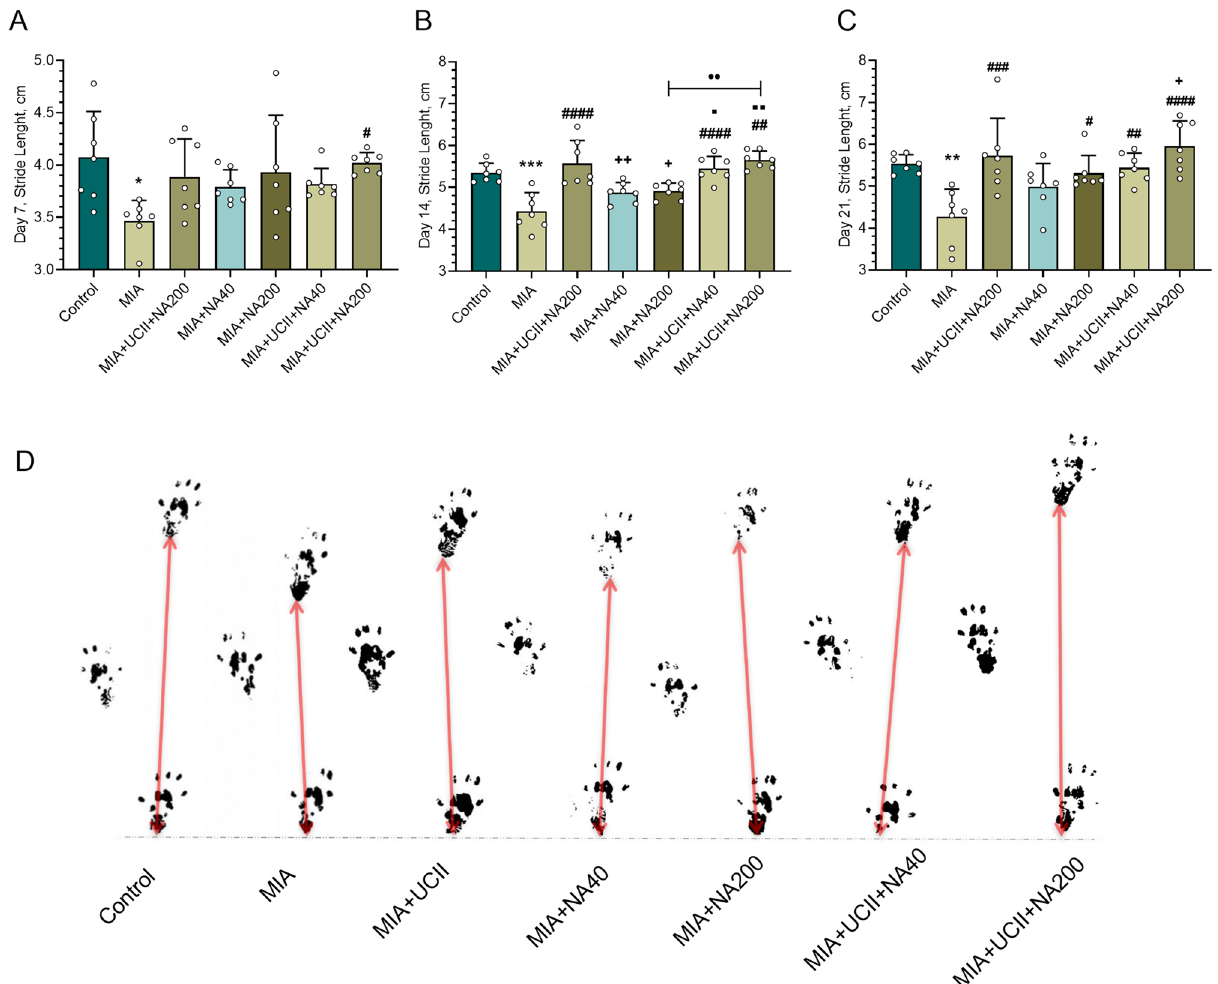
Figure 1. Effects of niacinamide (NA) and undenatured type II collagen (UCII) supplementation on stride length [on days 7 ( A ), 14 ( B ), and 21 ( C )] in monosodium iodoacetate (MIA)-induced osteoarthritis in rats (n = 7). Representative images of the stride length measured on day 21 of the study are shown ( D ). Control as a non-supplemental group with no osteoarthritis-induced rats, MIA as a non-supplemental group with monosodium iodoacetate (MIA)-induced knee osteoarthritis, MIA + UCII as MIA group gavage-fed a supplemental UCII at 4 mg/kg, MIA + NA40 as MIA group gavage-fed supplemental niacinamide (NA) at 40 mg/kg, MIA + NA200 as MIA group gavage-fed a supplemental NA at 200 mg/kg, MIA + UCII + NA40 as MIA group gavage-fed both supplemental UCII at 4 mg/kg and NA at 40 mg/kg and MIA + UCII + NA200 as MIA group gavage-fed both supplemental UCII at 4 mg/kg and NA at 200 mg/kg. Oral gavage delivery of supplements was applied from d7 to d30. The error bars point out the standard deviation of the mean. ANOVA and Tukey’s post-hoc test were used to compare the results among different treatment groups. Statistical significance between groups is shown by: * p < 0.05; ** p < 0.01; *** p < 0.001 compared as Control group and, # p < 0.05; ## p < 0.01; ### p < 0.001; + p < 0.05; ++ p < 0.01 compared as #### p < 0.0001 compared as MIA group and, MIA + UCII group and ⬛ p < 0.05; ⬛⬛ p < 0.01 compared as MIA + NA40 group and, •• p < 0.01 compared as pairwise comparisons between the groups) (ANOVA and Tukey’s post-hoc test; p <